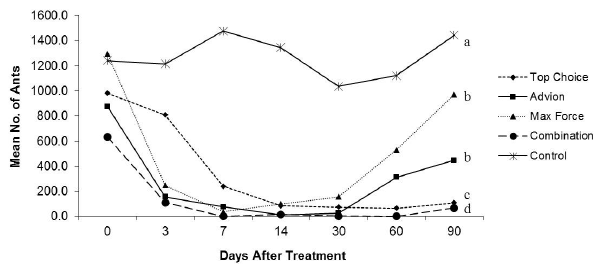
Fig 3. Mean number of foraging RIFA in experimental plots before and after product re-applications (90-day study). Trend lines followed by the same letter are not significantly different (α =